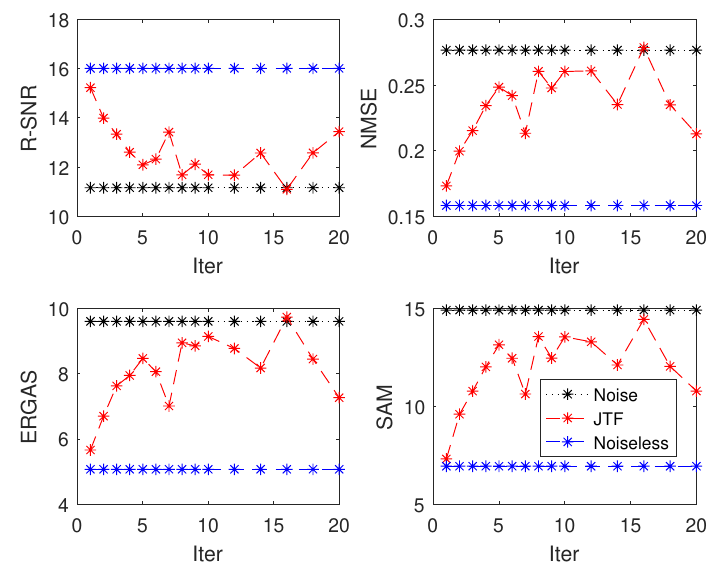
Figure 3. The results of the evaluation criterion as functions of the number of iterations Iter for the proposed joint tensor decomposition (JTF) method. SAM, spectral angle mapper; ERGAS, relative dimensionless global error in synthesis; R-SNR, reconstruction signal-to-noise